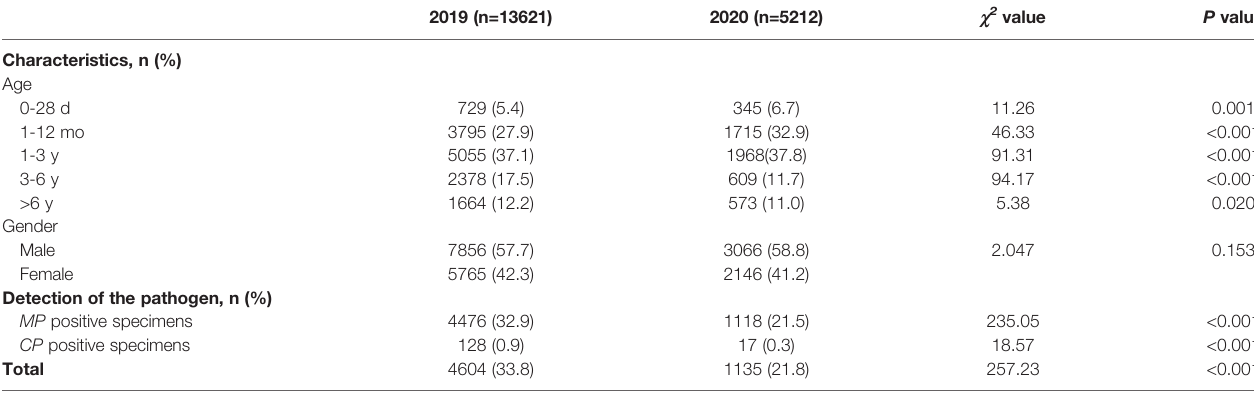
TABLE 1 | Patient characteristics and detection of Mycoplasma pneumoniae and Chlamydia pneumoniae between 2020 (during the COVID-19 pandemic) and 2019 (before the COVID-19